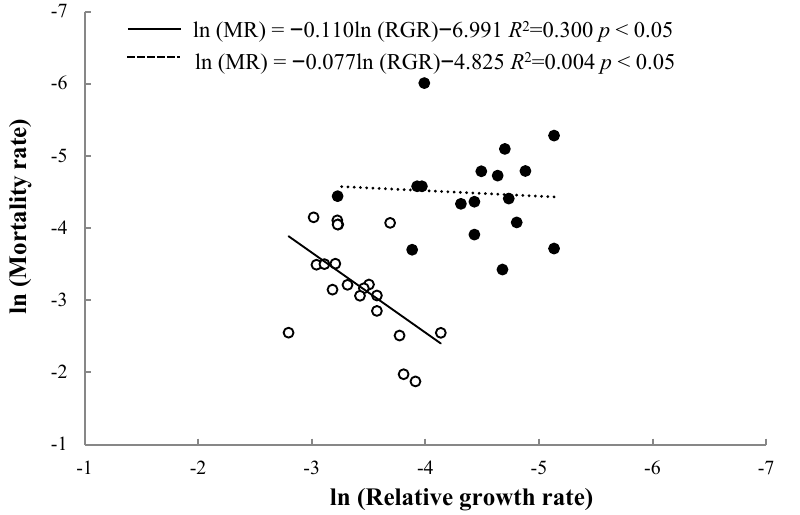
Figure 1. Linear regression relating RGR and MR for saplings (1 cm ≤ DBH < 10 cm) and large trees (DBH ≥ 10 cm) in the 9 ha dynamic plot of typical mixed broadleaved Korean pine forest. Hollow circles indicate saplings, whereas solid circles indicate large trees.